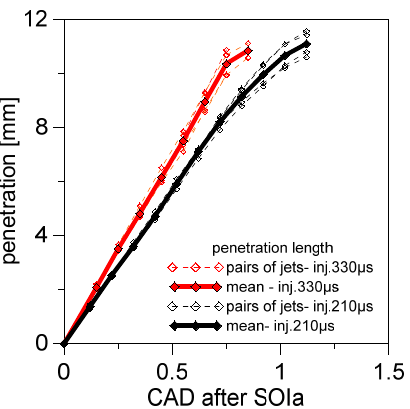
Figure 15. Actual mean penetration length for the two injection durations.